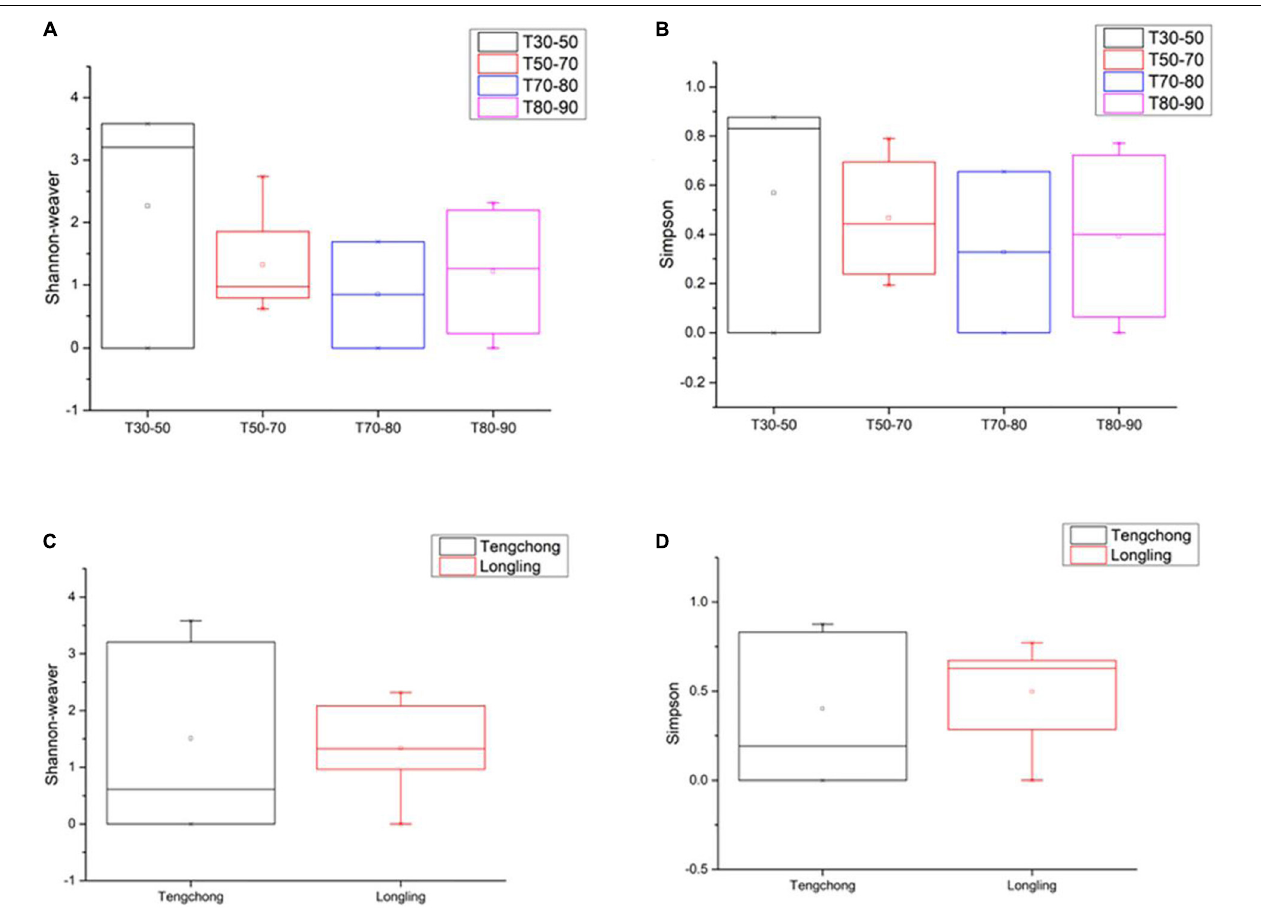
FIGURE 3 | The Shannon–Weaver and Simpson indices of cyanobacterial OTUs in thermal springs based on temperature range (A,B) and location (C,D). The Box plot was generated using the Origin tools. Median values and interquartile ranges have been indicated in the plots. T indicates the temperatures of the water samples or the hot spring water temperatures of other sample types. T30–50 (Group 1: 30–50 ◦ C), T50–70 (Group 2: 50–70 ◦ C), T70–80 (Group 3: 70–80 ◦ C), and T80–90 (Group 4: 80–90 ◦